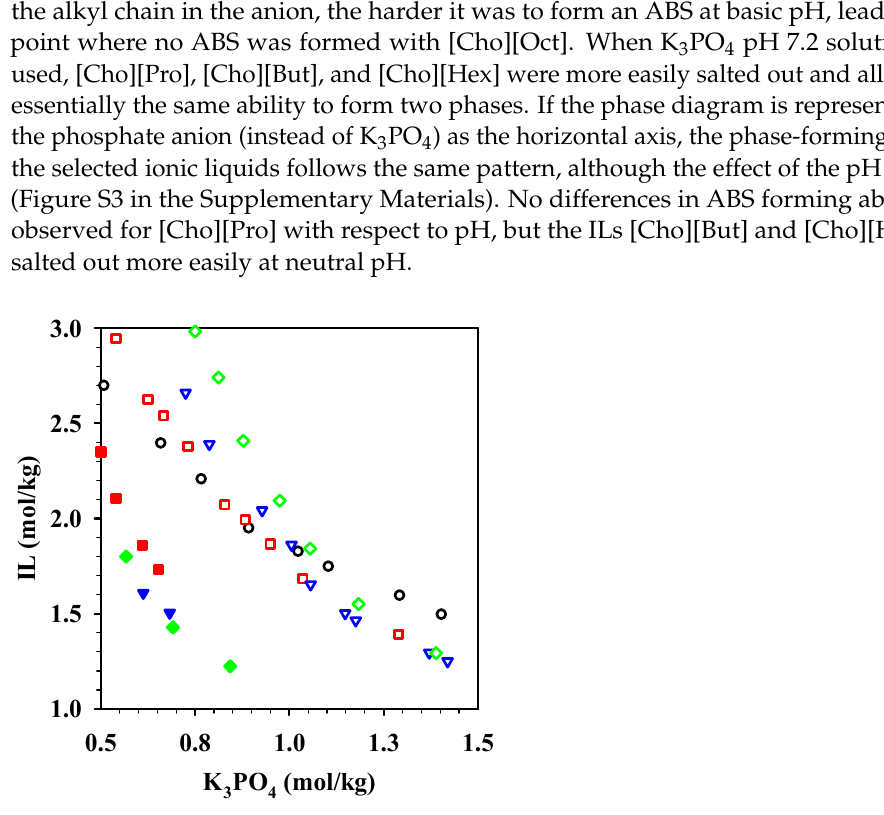
Figure 1. Phase diagrams of the ABS formed by [Cho][OAc] ( • ), [Cho][Pro] ( (cid:4) ), [Cho][But] ( (cid:72) ), and [Cho][Hex] ( (cid:117) ) with K 3 PO 4 at pH 7.2 (filled symbols) and pH 14.5 (open symbols). The full phase diagram is included in Supplementary Materials Figure